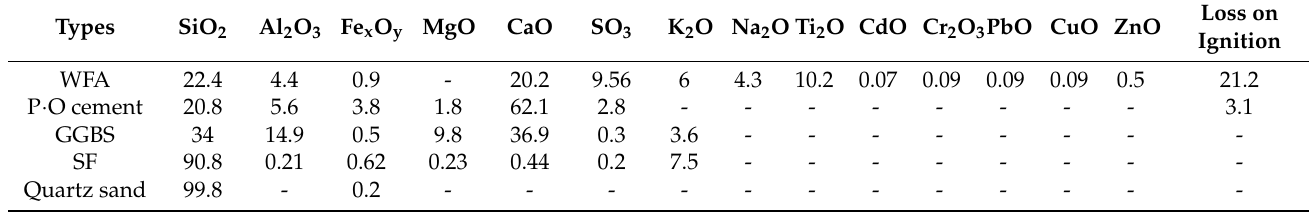
Table 2. The chemical composition of the cementitious materials (%). Table 1. The particle size distribution of the cementitious materials (%).